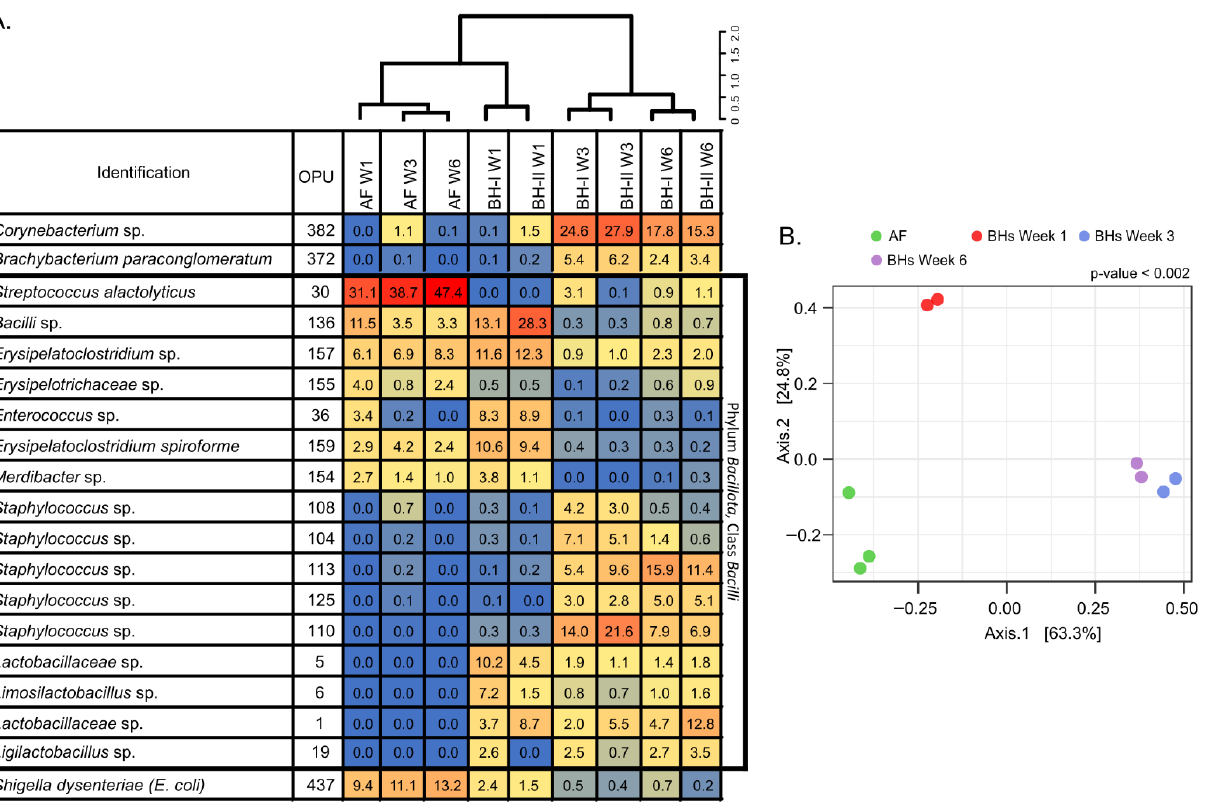
Figure 4. Heatmap, dendrogram, and beta-diversity analyses of air samples. Heatmap of relative abundances (%) of top OPUs per sample up to 5% ( A ). The inset color of blue indicates zero; yellow to increasing red values indicate above 1%. On top, dendrogram analysis, Bray–Curtis distance method, and Ward’s clustering algorithm. A list of OPUs and their closest relative sequence is given in Table S8. ( B ) PCoA of samples using Bray–Curtis measures of beta diversity. Statistical: PERMANOVA. AF: experimental animal facility, BH: broiler house, W1: week 1, W3: week 3, W6: week